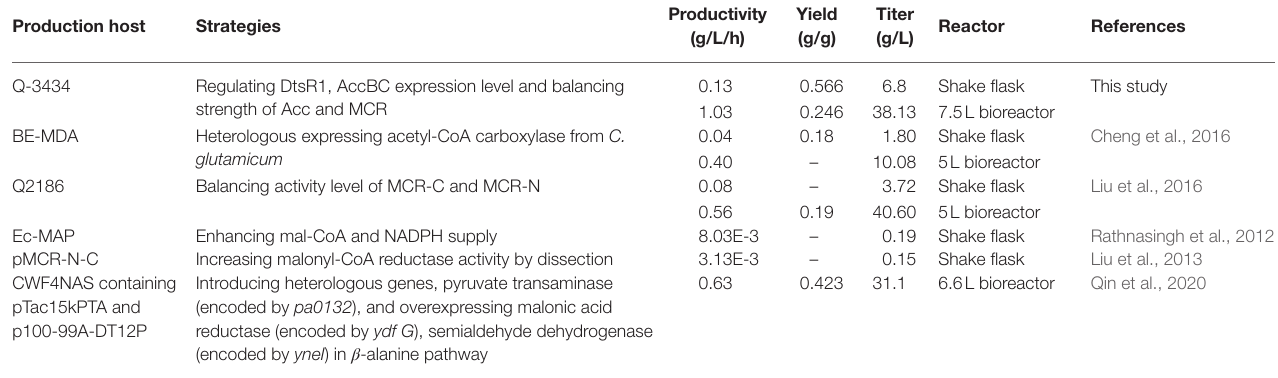
TABLE 2 | Comparison of 3-HP production with glucose as the sole carbon source in Escherichia coli .